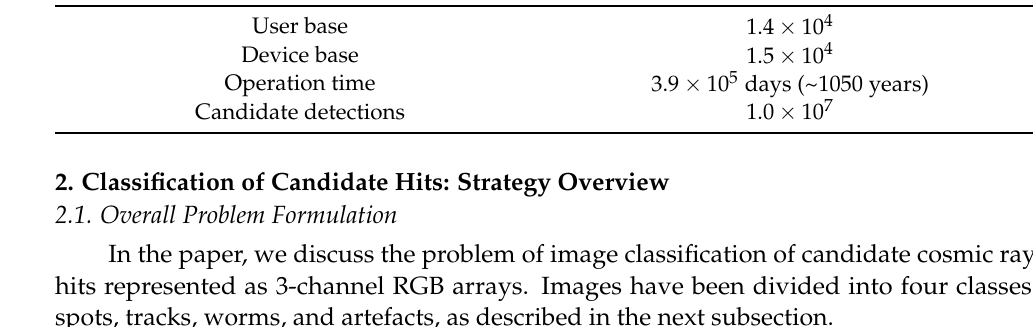
Figure 1. Approximate locations of phone-based detectors registered by the CREDO project (as of the beginning of 2021). Table 1. Key metrics related to the CREDO data set as of September